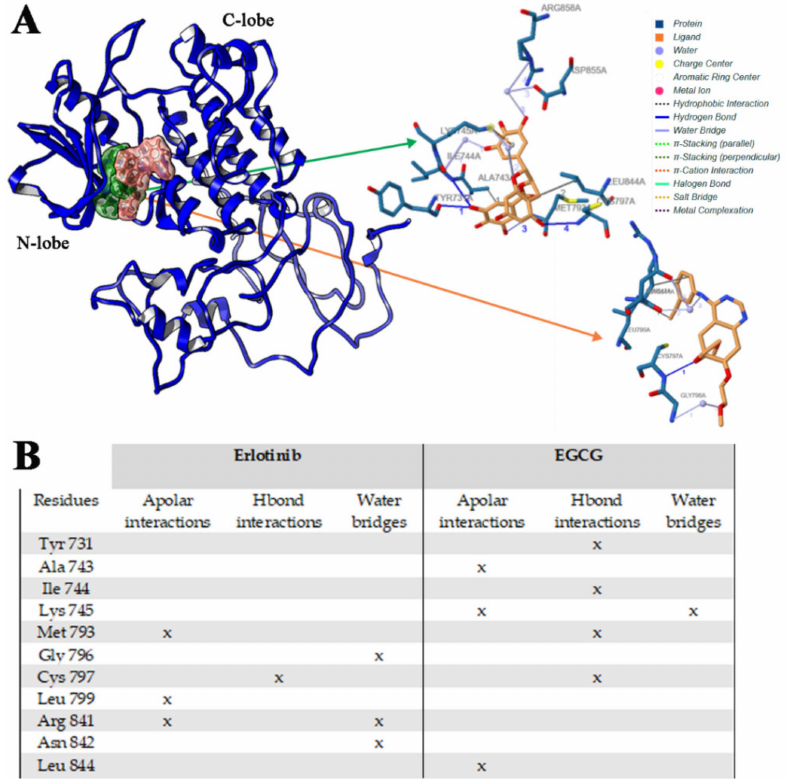
Figure 9. Binding a ffi nity of Erlotinib and EGCG in association with T790M / L858R EGFR domain ( A ), and interactions list of Erlotinib and EGCG with T790M / L858R EGFR ( B ). The 3D binding mode of Erlotinib (orange) and EGCG (green) has been